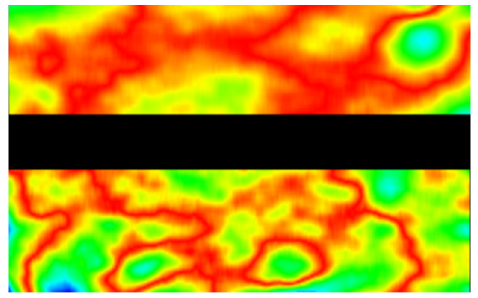
Figure 11. Distortion distribution. Red represents high distortion, followed by green and blue.